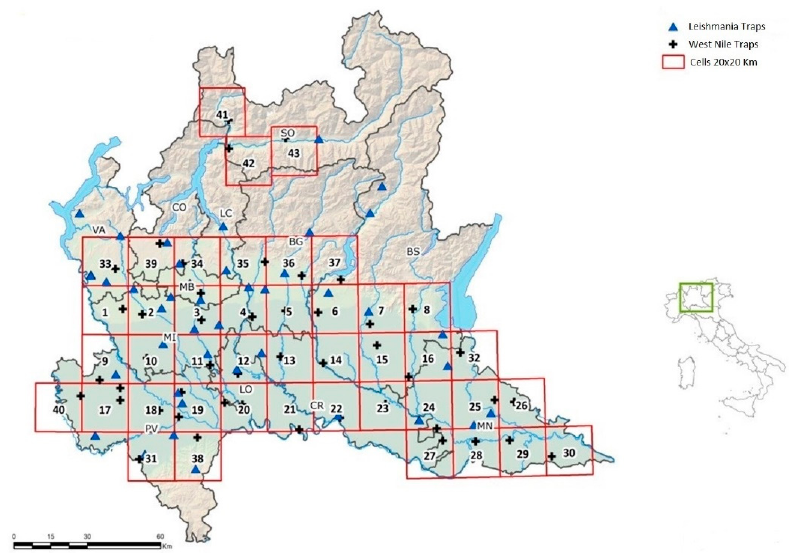
Figure 1. Geographical location of CO 2 –CDC traps at the collection sites. The collection sites are represented with blue triangles and black crosses for leishmania and WNV surveillance, respec- tively.